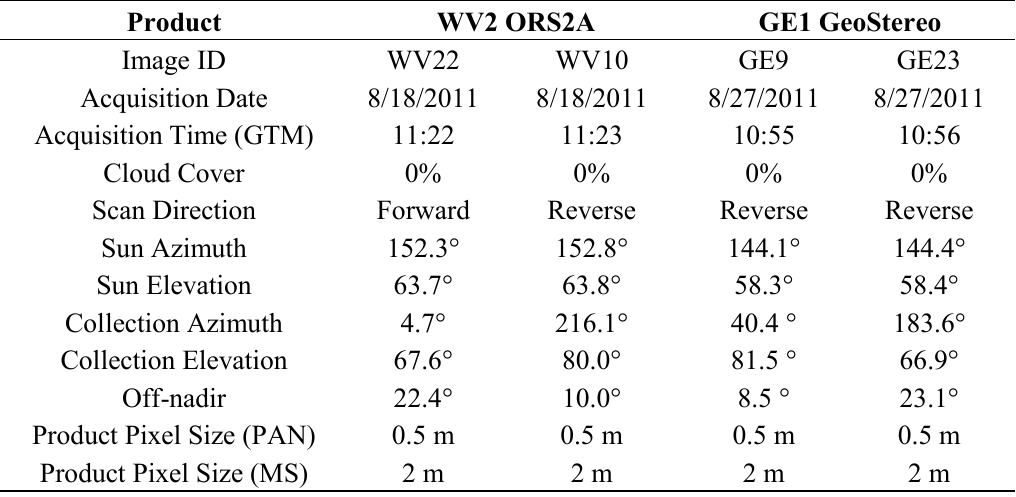
Table 1. Characteristics of WV2 and GE1 stereo pairs acquired over the study